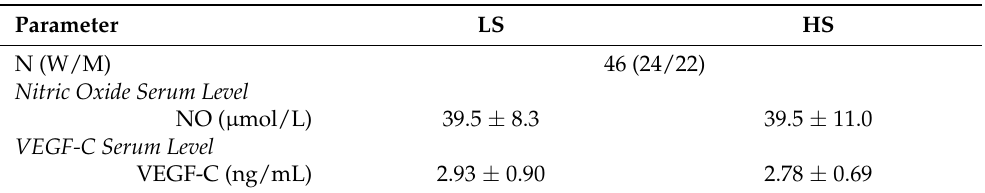
Table 4. Effects of a 7-Day High-Salt Diet on Nitric Oxide and Vascular Endothelial Growth Factor C (VEGF-C) Serum Levels in Young, Healthy Individuals.